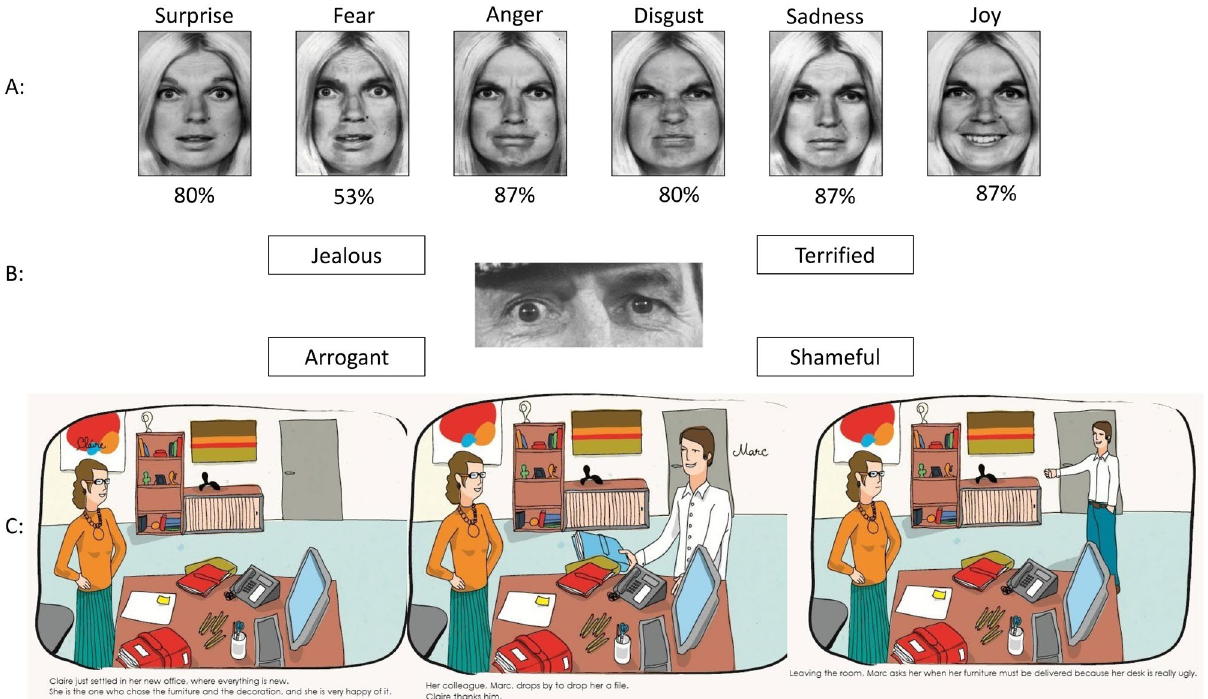
Figure 1. Illustrations from the battery of tests (from Ehrle et al. et Baron Cohen et al.). ( A ) In this task, a display shows faces based on Ekman faces of the same person expressing six basic emotions: anger, disgust, happiness, fear, surprise, and sadness. Faces are presented during a maximal duration of five seconds, followed by the presentation of emotion names. Participants have to decide which one of the six emotions best describe the face displayed. The percentage under each picture corresponds to the rate of successful recognition by the patients. ( B ) “Reading the mind in the eyes test” assessed perceptive-based mentalizing (Baron-Cohen et al. 31 ). ( C ) “Theory of mind”: the examiner reads the text to the participant who can also read it simultaneously. The participant is then asked different questions assessing social cognition but also the understanding and retention of the